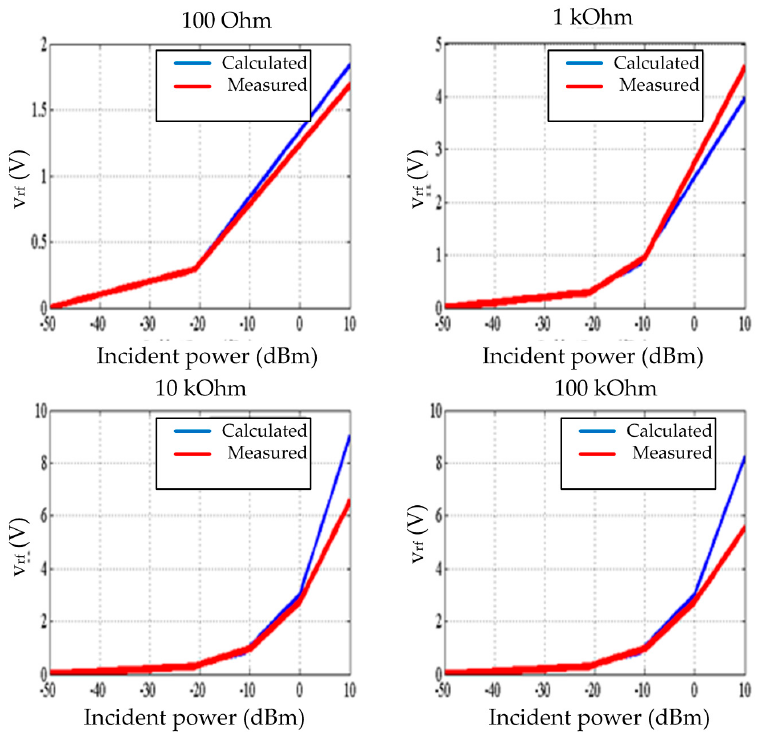
Figure 8. The calculated and measured voltage of the rectification circuit as a function of available power for SMS7621 Schottky diodes at f = 2.45 GHz. R g = 50 Ω .